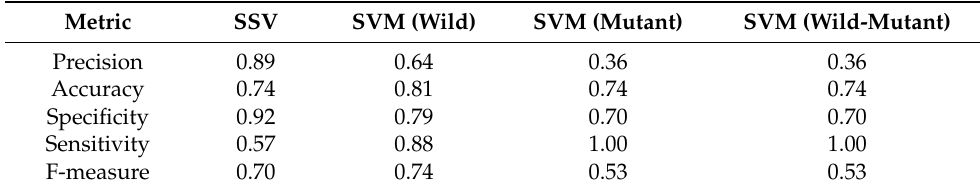
Table 3. Metrics used to evaluate